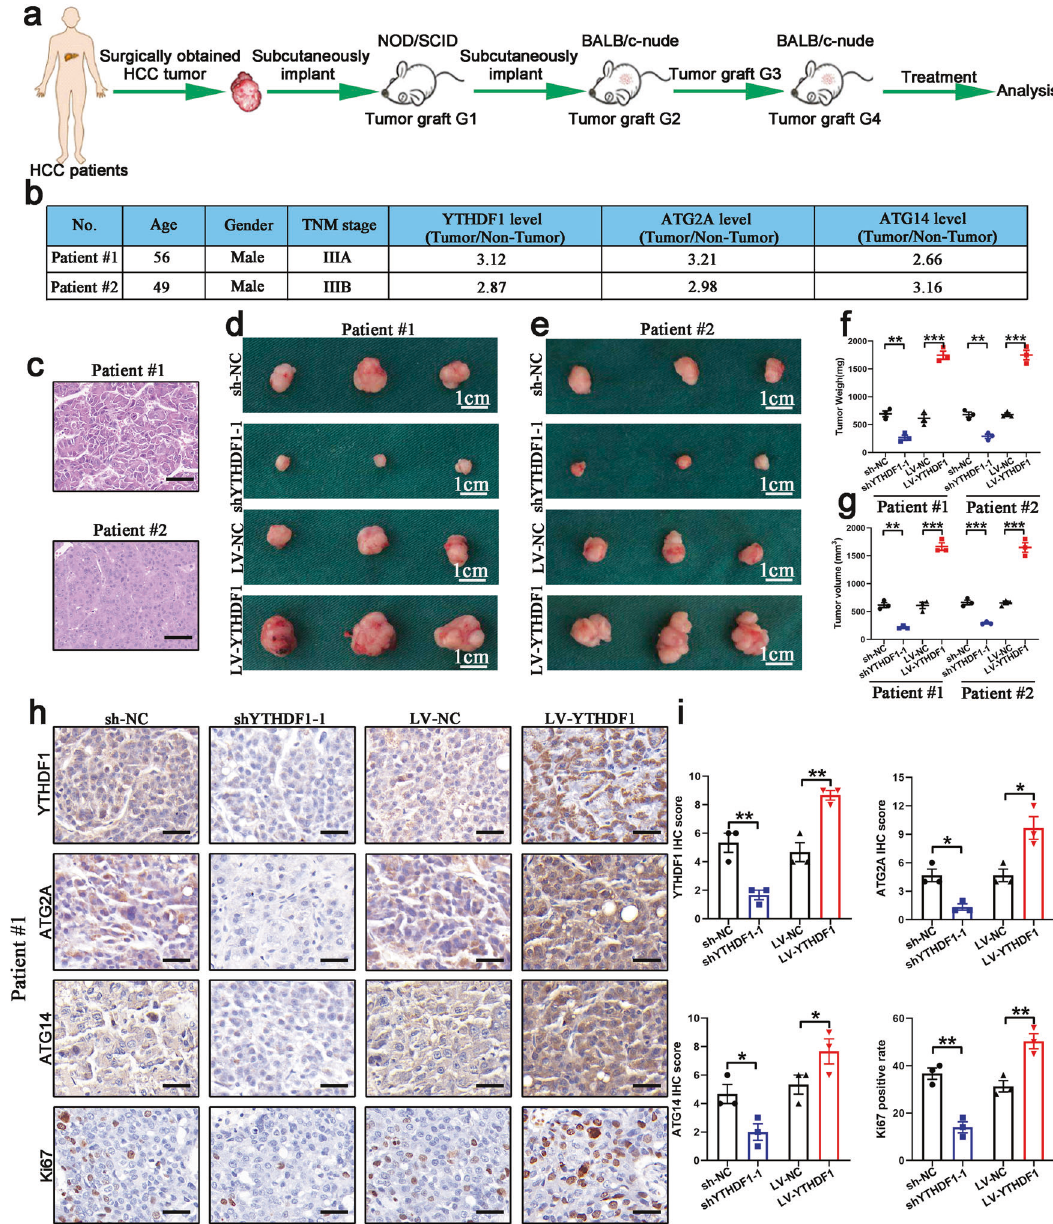
Fig. 6 YTHDF1 de fi ciency inhibits HCC growth in PDX models. a Graphic illustration of HCC PDX mouse models. b Clinical characteristics of the donor patients. c Hematoxylin and eosin (H&E) staining of donor patient tissues. Scale bar, 100 µm. d , e Harvested engrafted tumors in the sh-NC, shYTHDF1, LV-NC, LV-YTHDF1 groups. f Tumor weight of the engrafted tumors. g Tumor volume of the engrafted tumors. h , i Expression levels of YTHDF1, ATG2A, ATG14, and Ki67 in PDX tumor tissues determined by immunohistochemistry (IHC) staining. Scale bar, 50 µm. Error bars represent the mean ± SEM and the dots represent the value of each experiment; * P < 0.05, ** P < 0.01, *** P < DISCUSSION Accumulating evidence indicates that m6A methylation dysregu- lation is closely associated with the development and progression of various malignancies. 24 Further, m6A methyltransferases or demethylases either facilitate or impair carcinogenesis in different malignancies. For example, the m6A methyltransferase METTL14 inhibits tumorigenesis in colorectal cancer, bladder cancer, and HCC. 19,25,26 However, METTL14 also plays an oncogenic role by regulating the expression of its mRNA targets (e.g., MYB and MYC) via m6A modi fi cation in leukemogenesis. 27 Owing to recognition by diverse m6A readers, mRNA transcripts with m6A modi fi cations are subjected to different fates. YTHDC2, YTHDF2, and YTHDF3